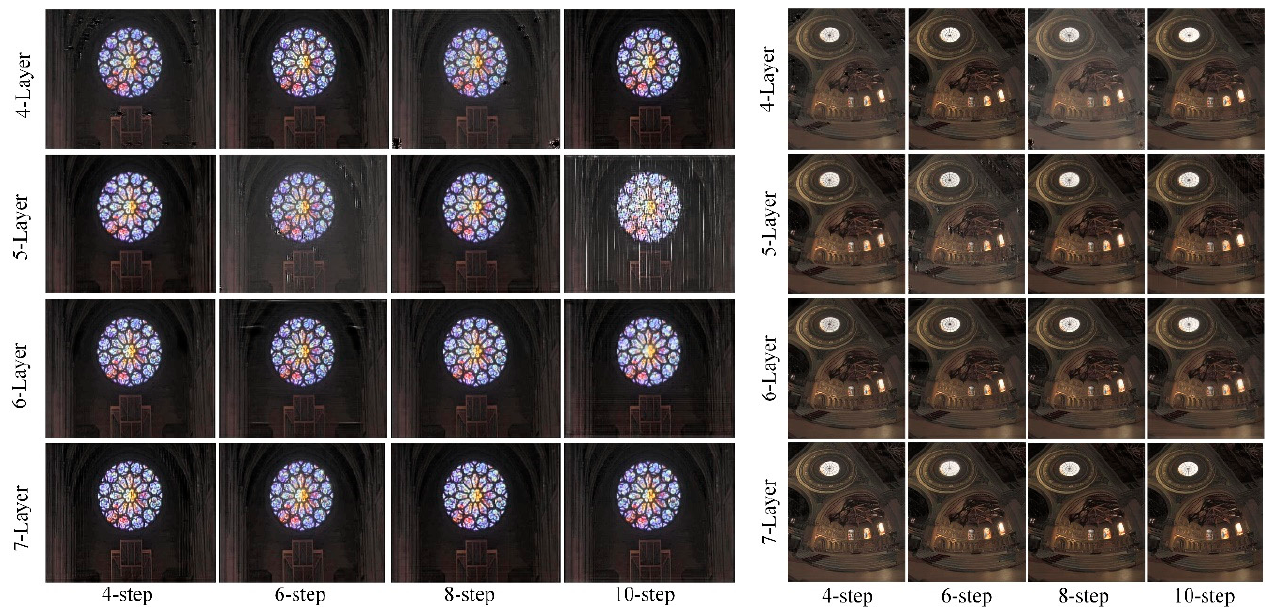
Figure 20. Results of dark surrounding images according to the number of layers and steps.